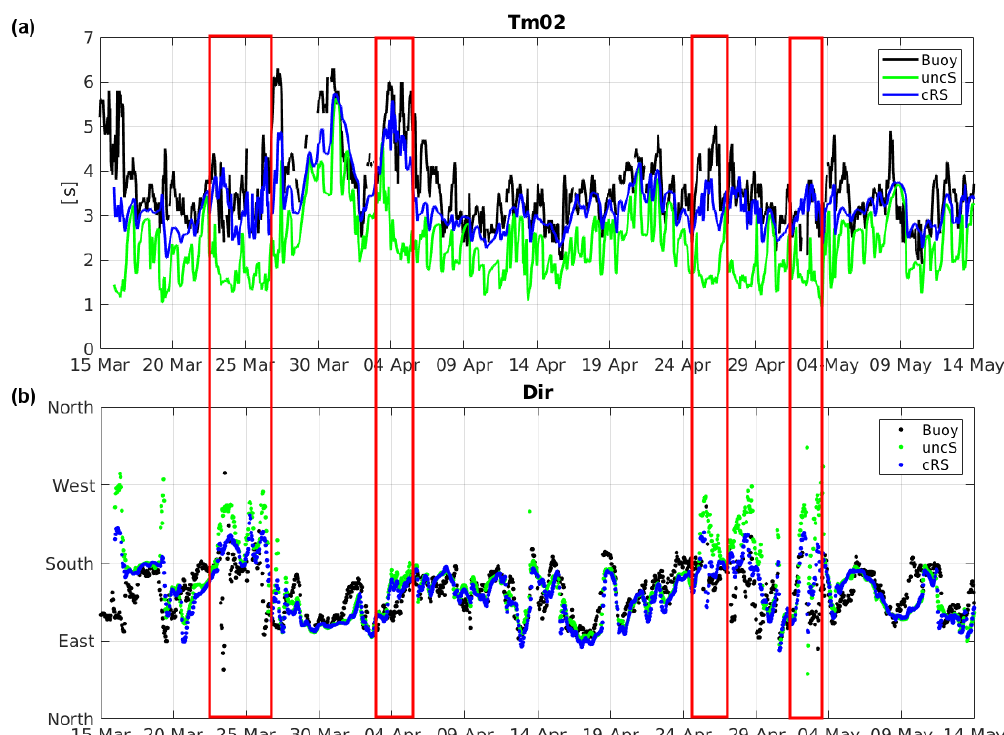
Figure 12. Comparison of the Tm 02 and Dir parameters’ time series obtained with the uncS (green) and cRS (blue) runs with the data measured by CB (black). Note that the first 24h of the model results have been